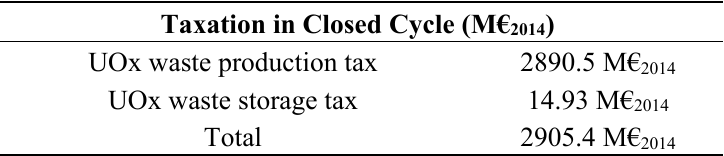
Table 4. Taxation in closed cycle for all period of study